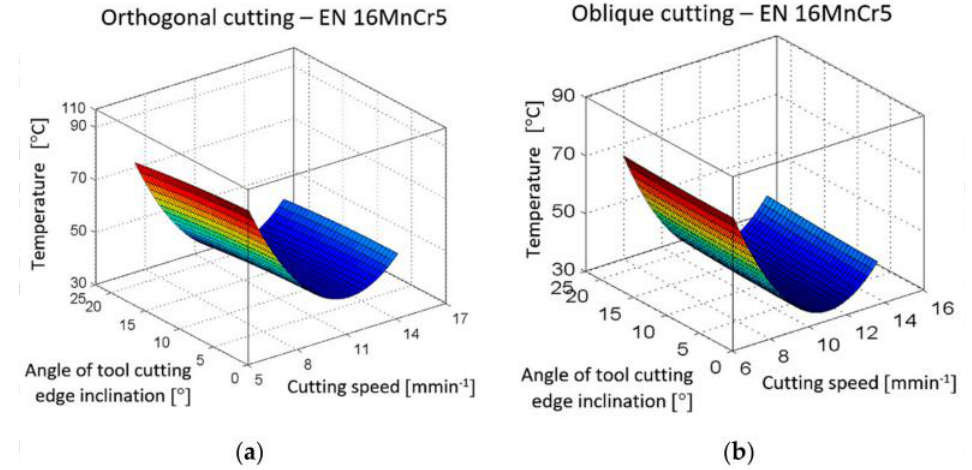
Figure 10. The dependence of temperature T on cutting speed v c and angle of tool cutting edge inclination λ s . ( a ) Orthogonal cutting; ( b ) oblique